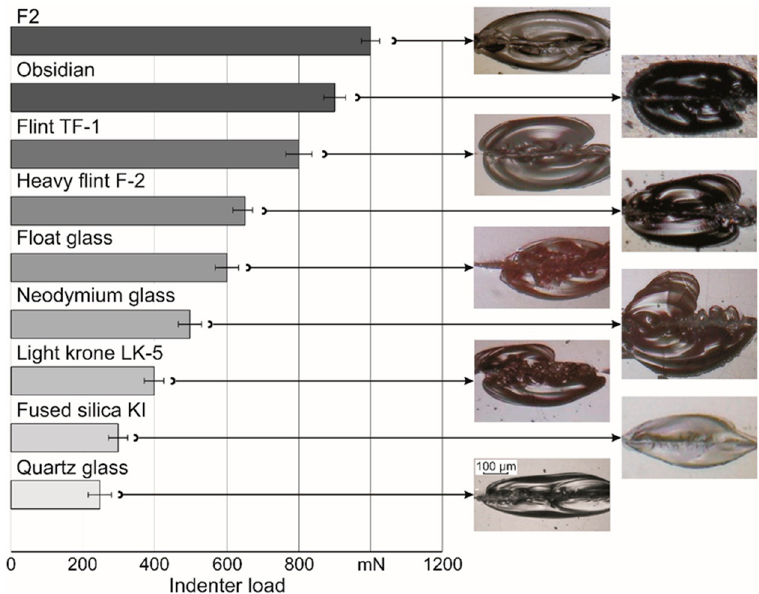
Figure 9. Lateral cracks by discrete scratching of glasses.